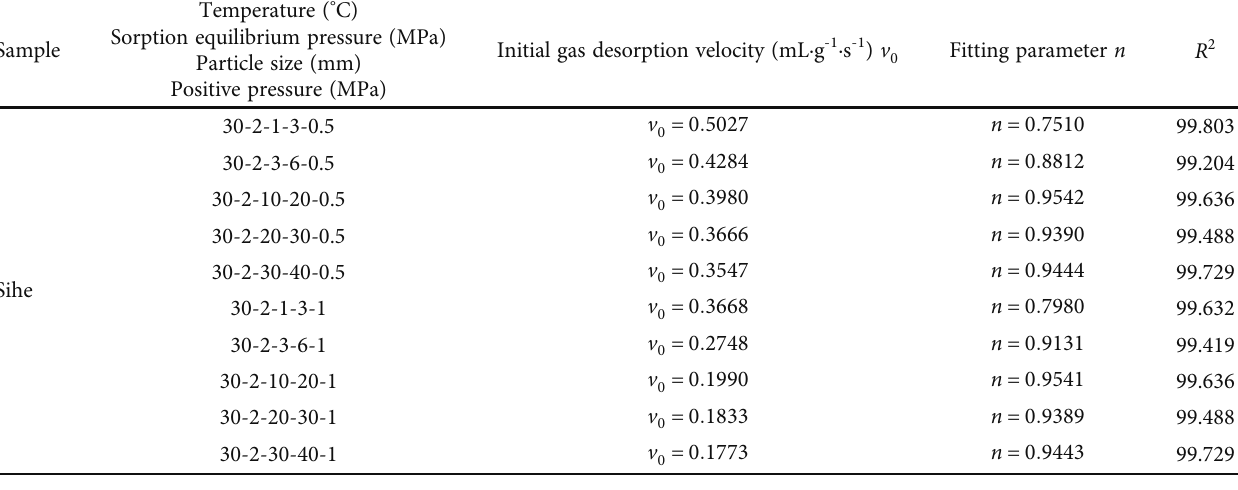
Table 4: Parameters of gas desorption